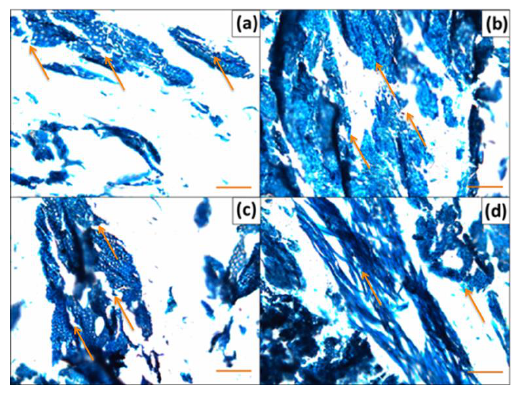
Figure 10. Microstructure of biocomposites with different weight percentage of wood particles mixed to natural binder before the molding process (white color for PLA matrix and blue color for wood particles in PLA matrix): ( a ) 10% of aspen wood, ( b ) 40% of aspen wood, ( c ) 20% of willow wood, and ( d ) 40% of willow wood. Scale bars: 100 µm.